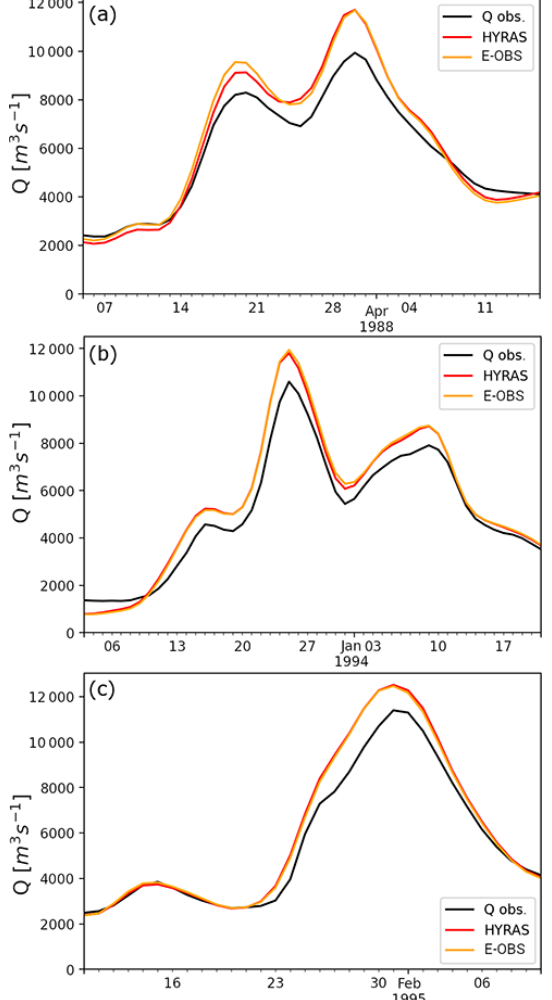
Figure 6. Time series of simulated and observed discharges (black) at the Emmerich station (EMME) for the flood events (a) March 1988, (b) December 1993, and (c) January 1995. The simulations are forced with HYRAS (red), and E-OBS (or- ange), respectively.